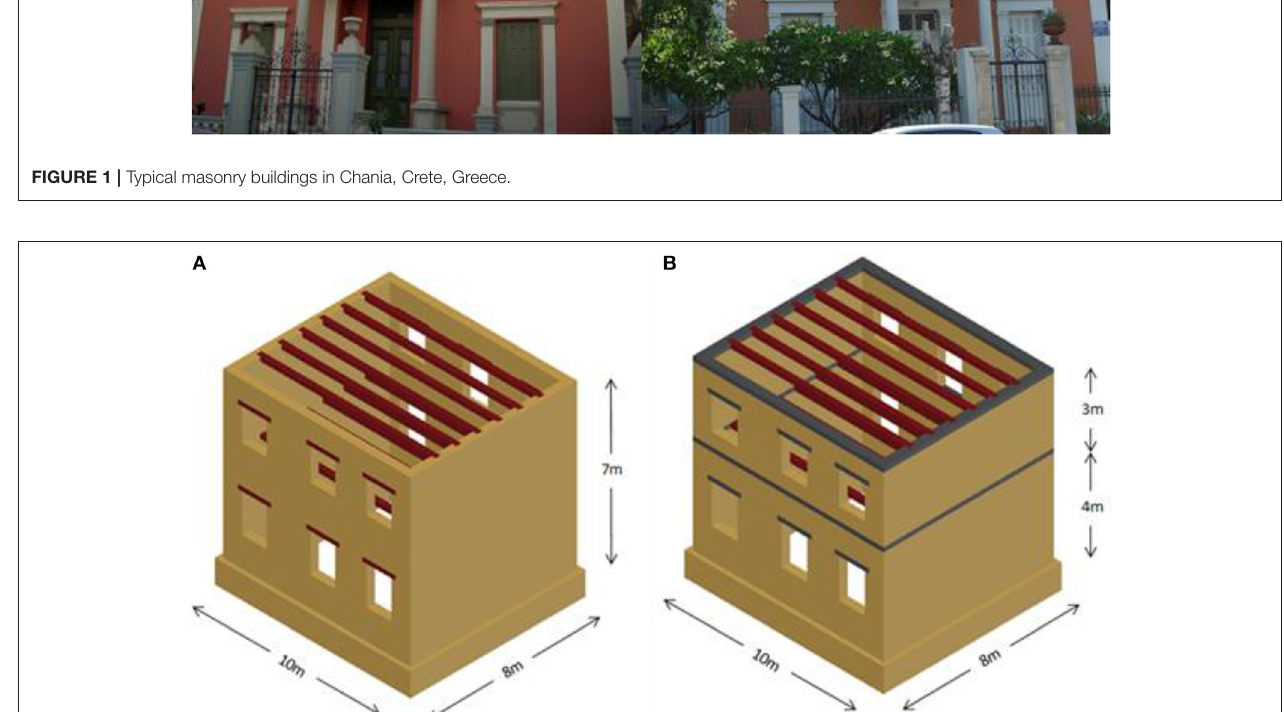
FIGURE 2 | The initial (A) and the slightly retrofitted (B) masonry